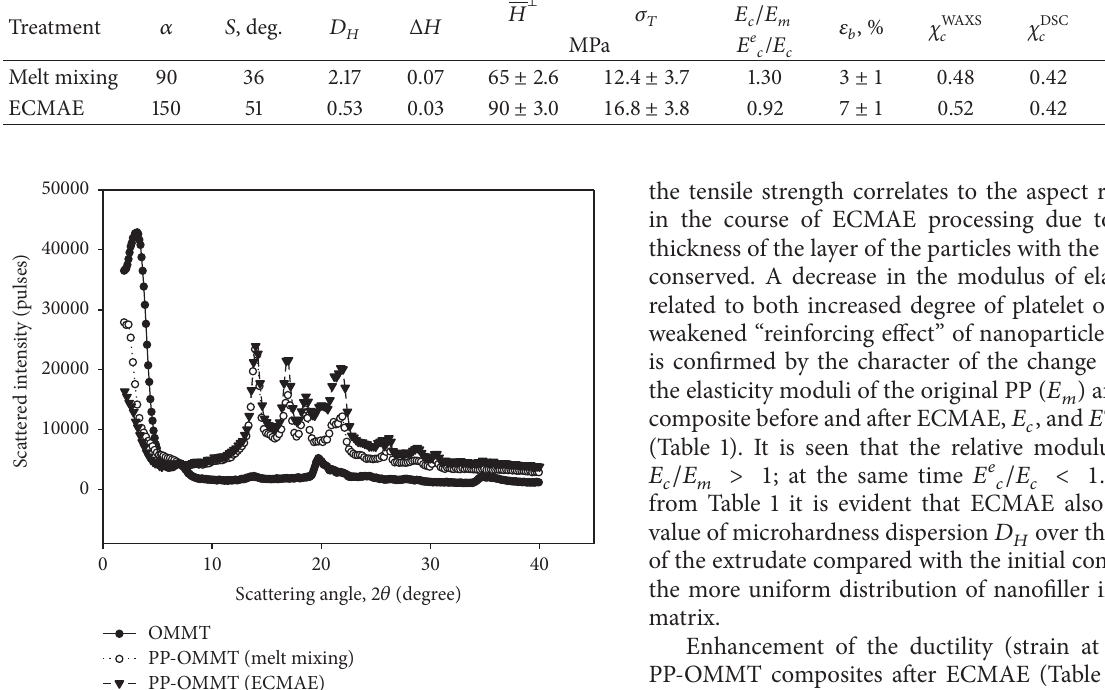
Figure 2: XRD patterns of OMMT and PP-OMMT